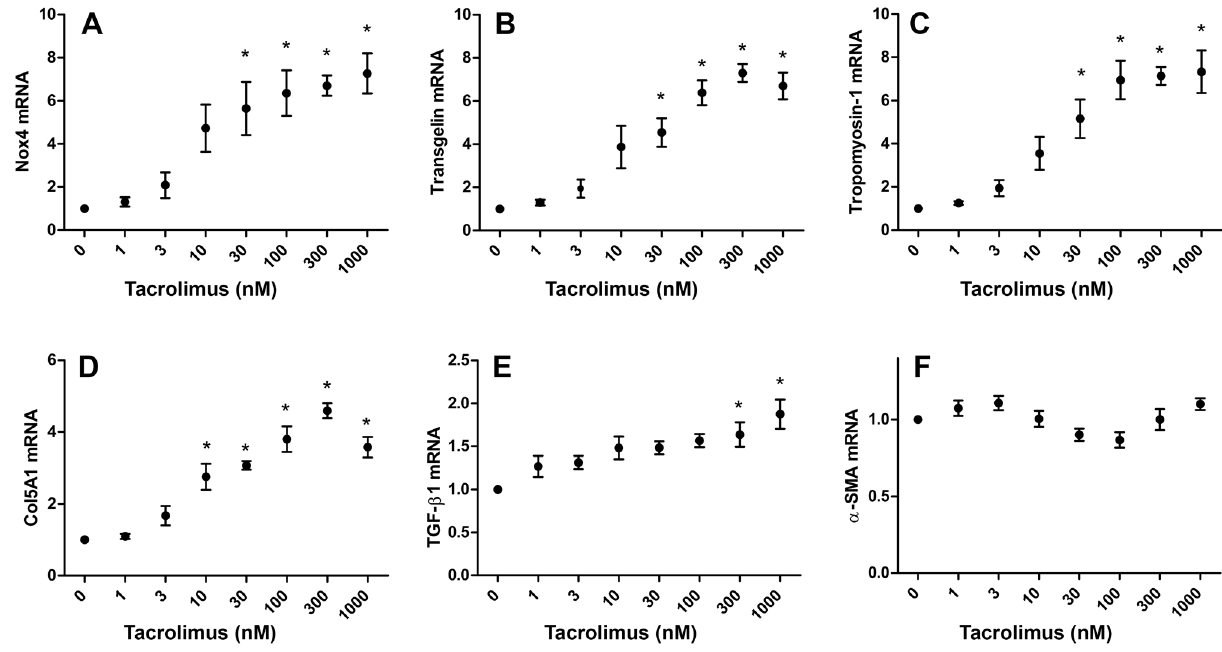
Figure 2. Induction of fibrosis-related genes in TK-173 fibroblasts by nanomolar levels of tacrolimus. Exposure to increasing concentrations of tacrolimus (0–1000 nM) induced mRNA expression in a concentration-dependent manner after three days for Nox4 (A), transgelin (B), tropomyosin-1 (C), procollagen a 1(V) (D), and transforming growth factor b -1 (E). a -smooth muscle actin mRNA expression (F) was not affected. RT-qPCR results were standardized to 18S rRNA, linearized, and normalized to the control group (without tacrolimus). (*) indicates significance from untreated cells p # 0,05.